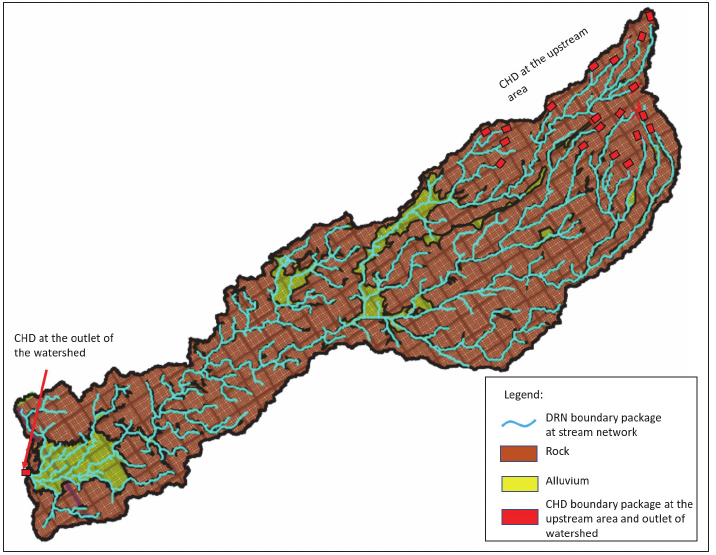
Figure 16. Transient groundwater modeling appearances on MODFLOW 6, involve several bound ‐ ary conditions packages (i.e., CHD, DRN, EVT, and RCH). The EVT and RCH are applied to the whole watershed.